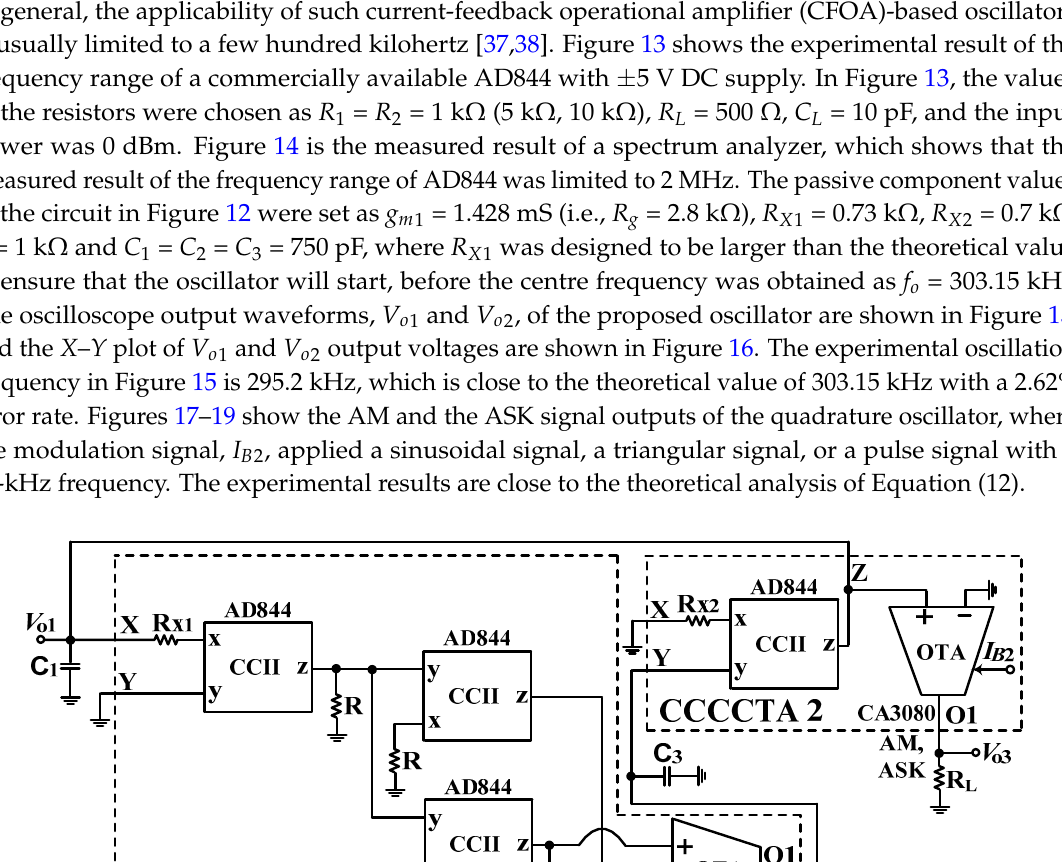
Figure 14. The experimental evidence frequency ranges of AD844 when R 1 = R 2 = 1 k Ω (yellow line; R 1 = R 2 = 5 k Ω (cyan line); and R 1 = R 2 = 10 k Ω (purple line). Figure 15. The experimental waveforms of the quadrature outputs V o 1 (channel 1) and V o 2 (channel 2).